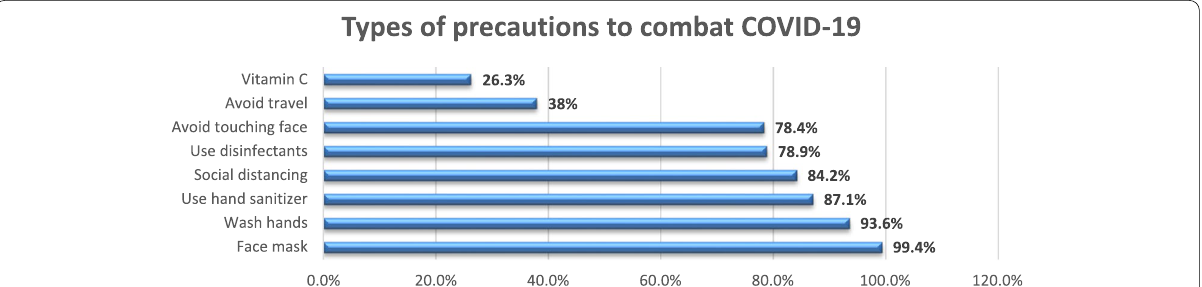
Fig. 3 Types of precautions taken to combat COVID-19 by the participating dental teaching staff of the Faculty of Dentistry, Ain Shams University, Egypt ( N =